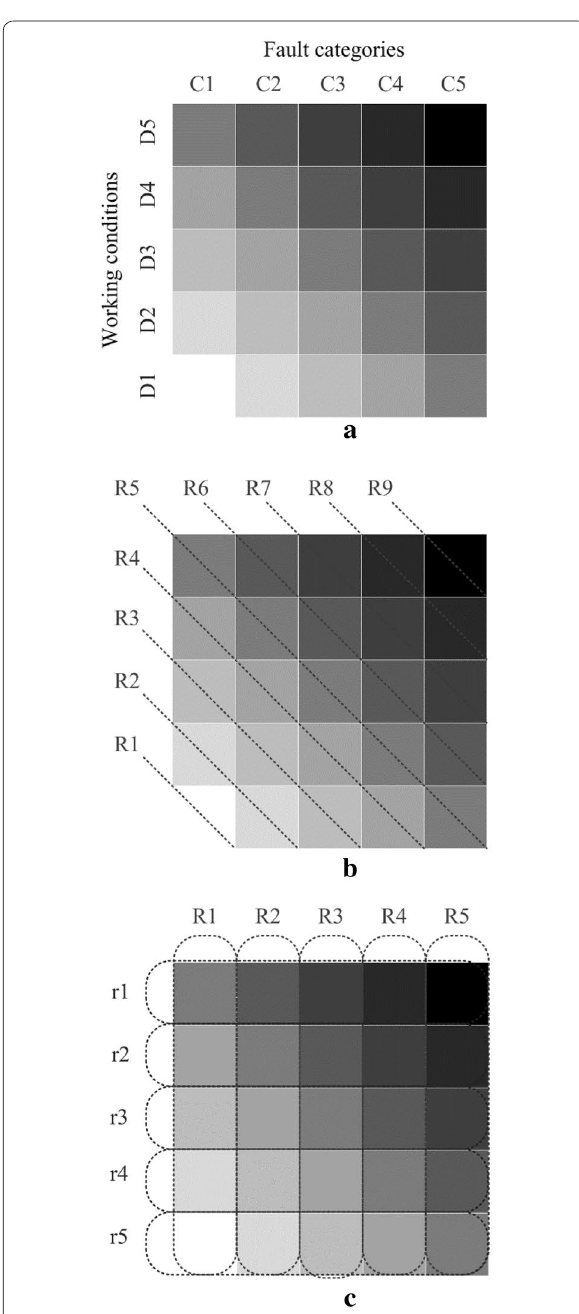
Figure 1 The comparison between classical clustering and co-clustering results: a extracted features, b classical clustering results, c co-clustering results